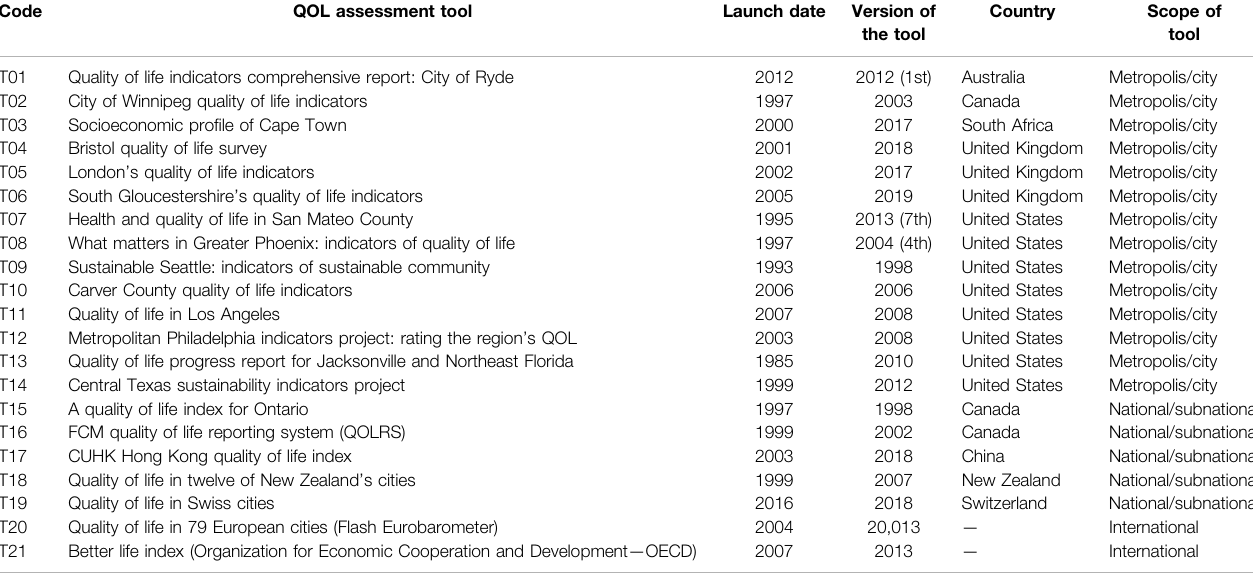
TABLE 1 | Summary of the examined 21 urban QOL assessment